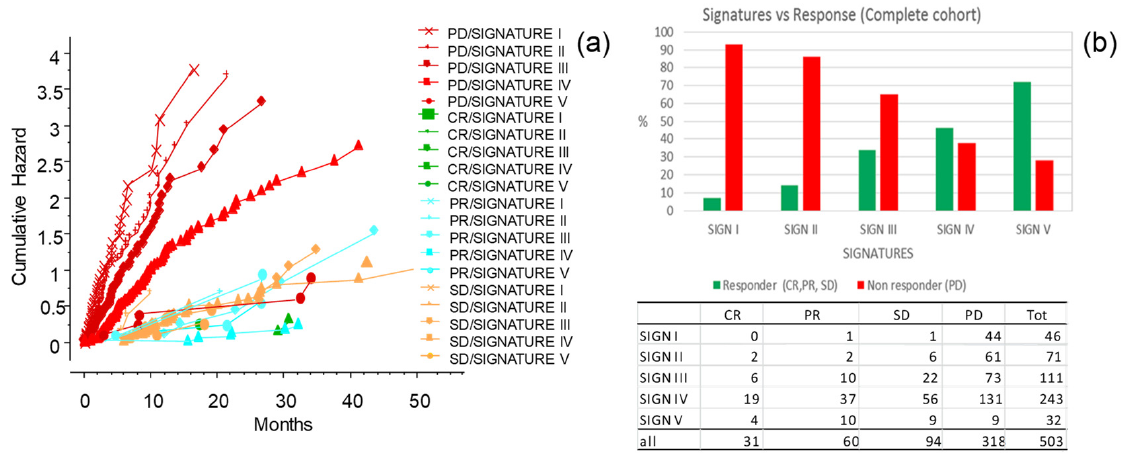
Figure 9. The CLICAL signatures and response to the ICI treatment (complete response (CR), partial response (PR), stable disease (SD); responders), (progressive disease (PD); non-responders). ( a ) Cross-analysis of the CLICAL signatures panel with the results from ICI intervention. Cumulative risks for each signature easily show whether the characteristics of each signature are favorable or not. ( b ) Percentage of cases in responders present in each signature after the ICI treatment. Signature V comprises a higher percentage of responder patients and a lower percentage of non-responder patients compared to Signature I. The numbers of cases for each response category and signature are presented in the attached table.